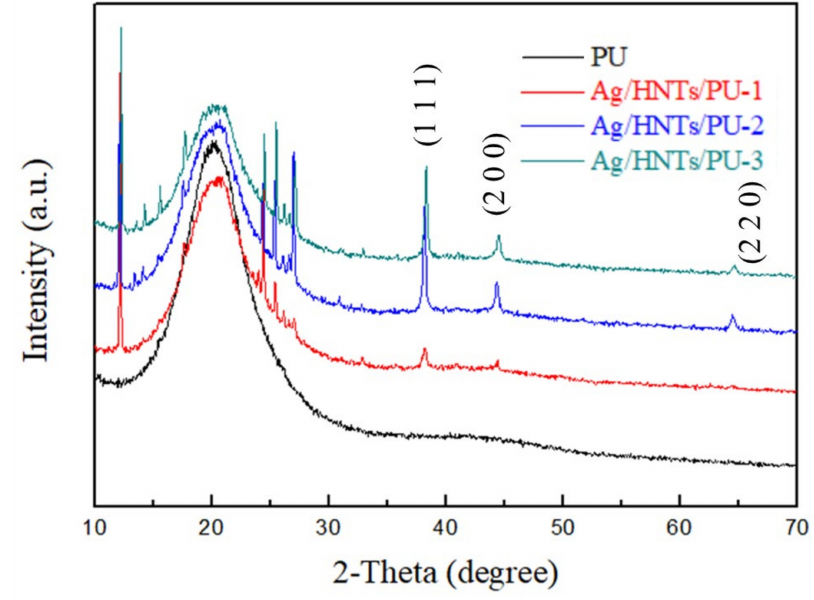
Figure 5. XRD patterns of the Ag / HNTs / PUs.